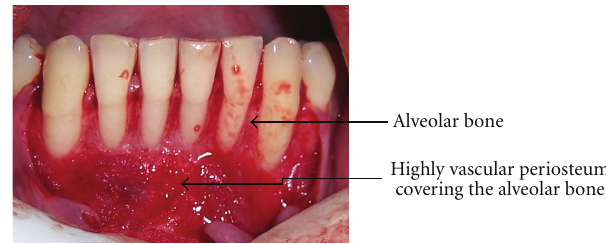
Figure 1: Highly vascular periosteum covering the alveolar bone.